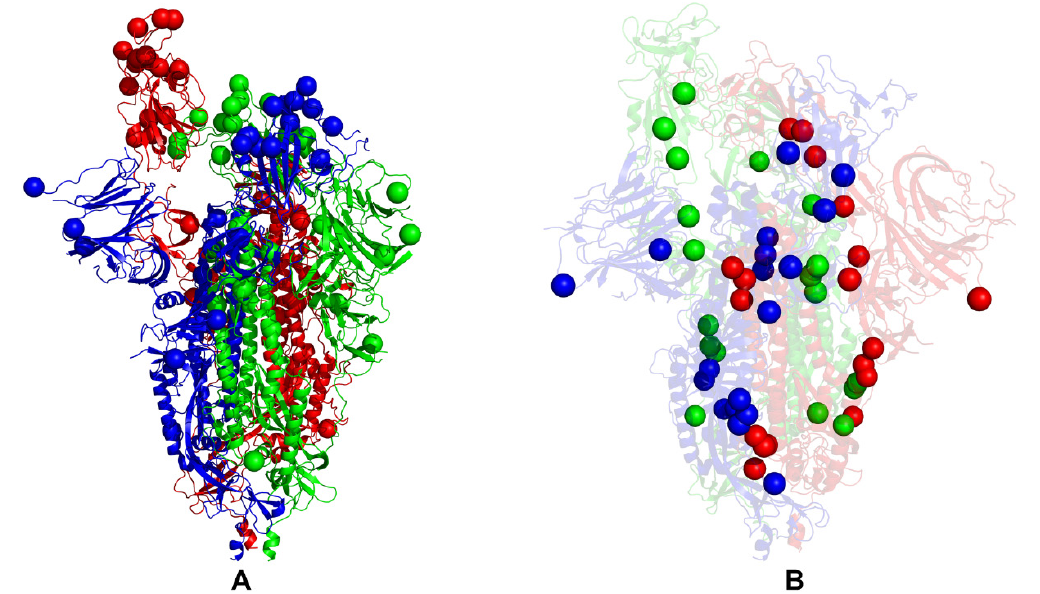
Figure 9. Structural maps of the functional sites for the SARS-CoV-2 S Omicron BA.1 open trimer. ( A ) The structural mapping of the Omicron sites projected onto the cryo-EM structure of the open S Omicron trimer (pdb id 7WK3). The three protomers A,B,C of the S Omicron trimers are shown in green, red and blue ribbons respectively. The Omicron mutational sites G339D, S371L, S373P, S375F, K417N, N440K, G446S, S477N, T478K, E484A, Q493R, G496S, Q498R, N501Y, Y505H, T547K, D614G,